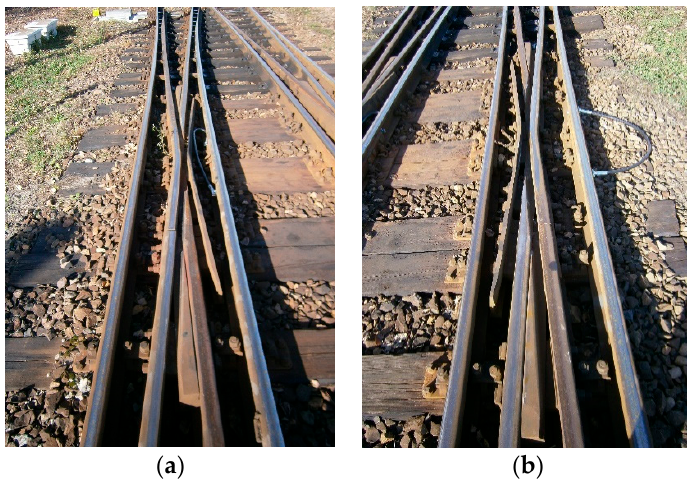
Figure 15. Ballast condition at Rkpd iwew No. 9: ( a ) left-hand obtuse crossing; and, ( b ) right-hand obtuse crossing.